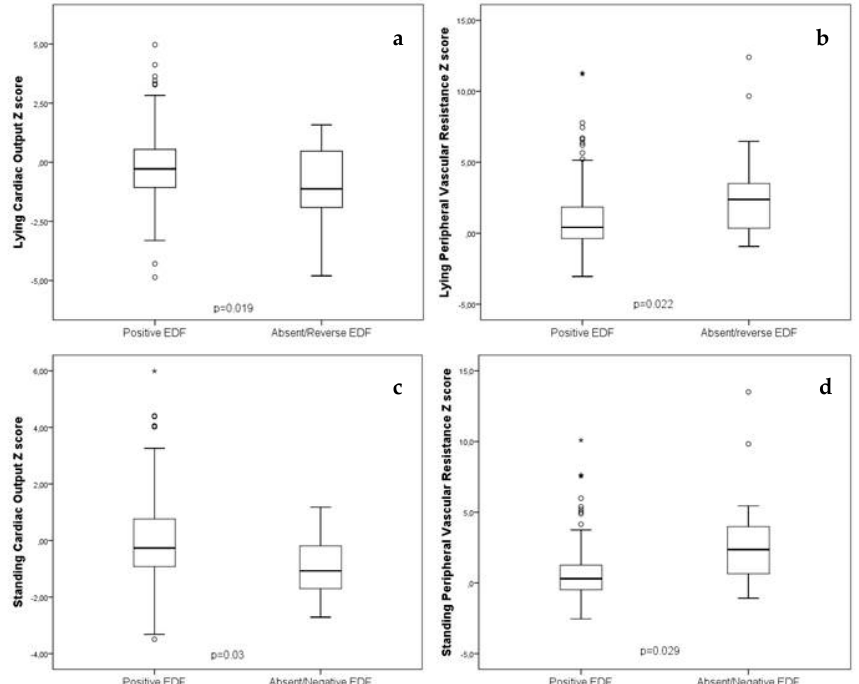
Figure 3. (From left to right): positive end diastolic flow (EDF) vs. absent or reversed EDF in the umbilical artery: ( a ) lying cardiac output z -score, ( b ) lying peripheral vascular resistance z -score, ( c ) standing cardiac output z -score, ( d ) standing peripheral vascular resistance z -score.